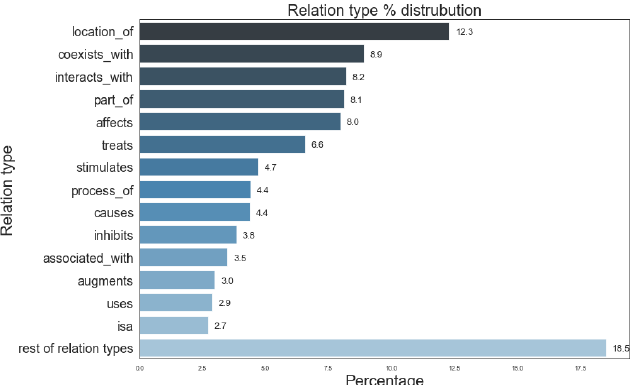
Figure 6. Distribution of different relation types in SemNet ([16]). “Rest of relation types” represents the aggregate of remaining relations types not listed in the figure due to space